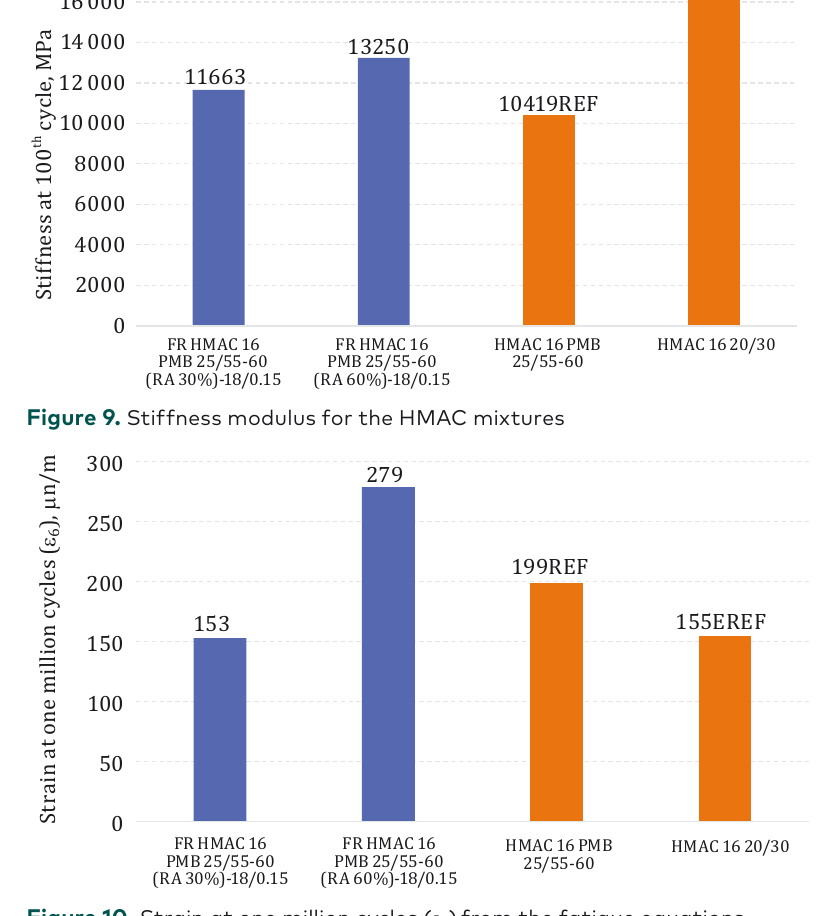
Figure 10. Strain at one million cycles ( e 6 ) from the fatigue equations for HMAC mixtures